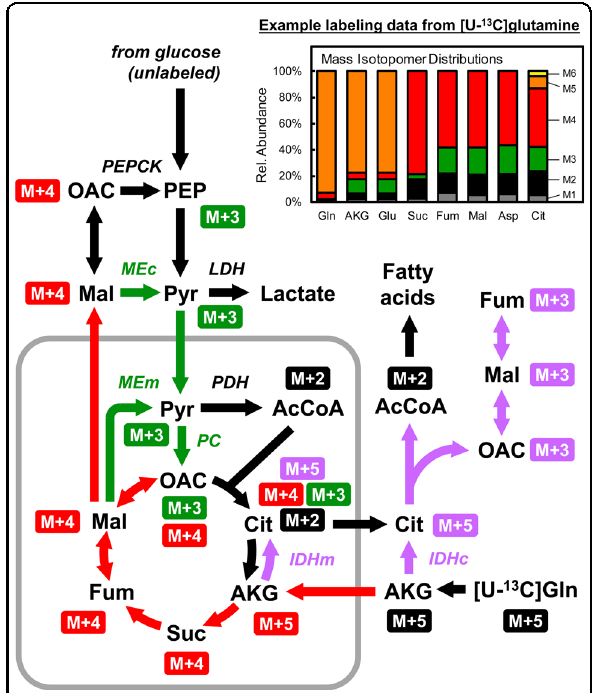
Fig. 7 [U- 13 C]Glutamine tracer experiments produce rich labeling patterns in TCA cycle metabolites that allow precise quanti fi cation of metabolic fl uxes in lower part of central metabolism, i.e., downstream of pyruvate, using 13 C-MFA. The diagram shows schematically the fl ow of 13 C-labeling from [U- 13 C] glutamine into relevant metabolic pathways in cancer cells. The insert shows an example of labeling data obtained from a [U- 13 C]glutamine tracer experiment. Colors of arrows indicate different metabolic pathways: reductive carboxylation of glutamine (purple); glutaminolysis (red); conversion of malate to oxaloacetate via malic enzyme and pyruvate carboxylase